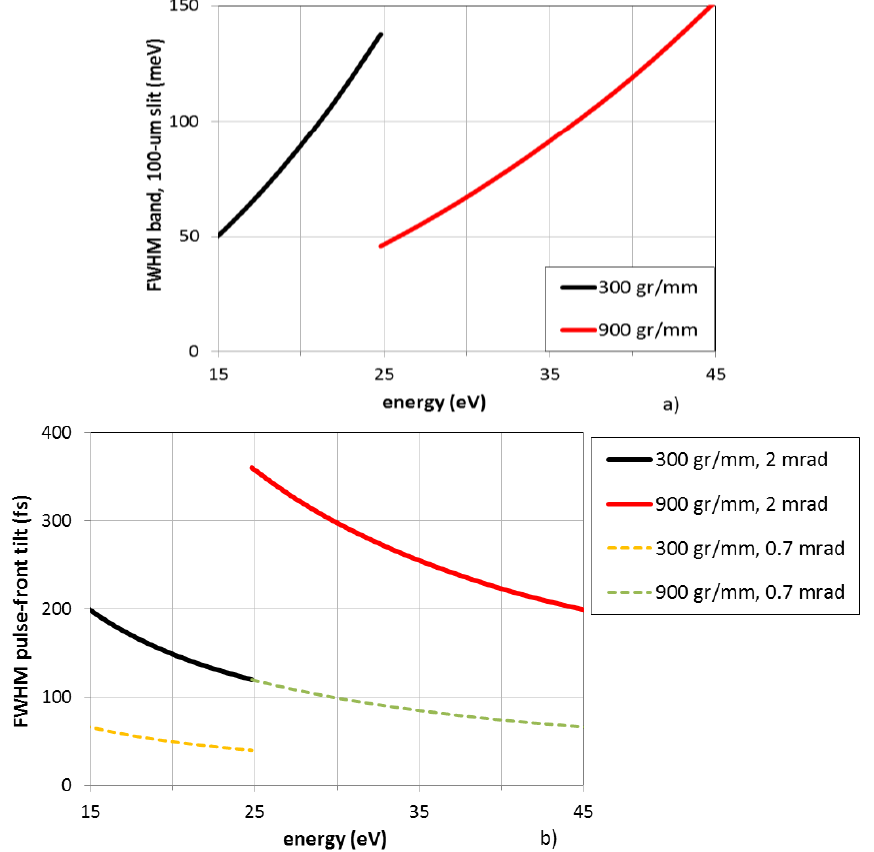
Figure 5. OPM ultrafast monochromator in the 15–45 eV region, 100 meV average bandwidth. The grating parameters are reported in Table 2. ( a ) Energy bandwidth on the 100-μm exit slit; ( b ) Pulse-front tilt with 2 mrad and 0.7 mrad full-width-at-half-maximum (FWHM) accepted aperture.